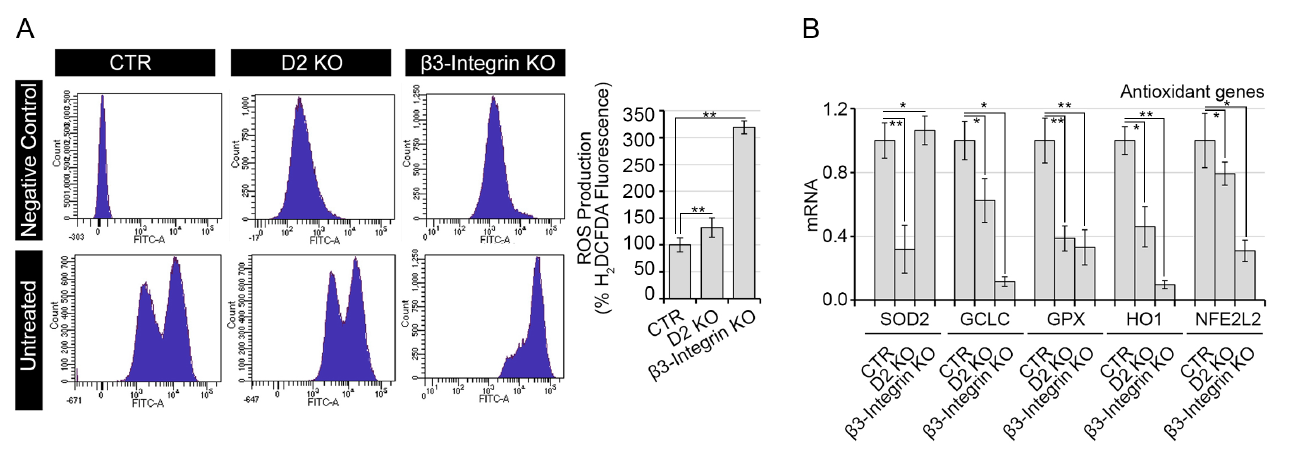
( C ) Western blot analysis of MyoD and Myogenin in the same cells as in A, B. Tubulin expression was measured as a loading